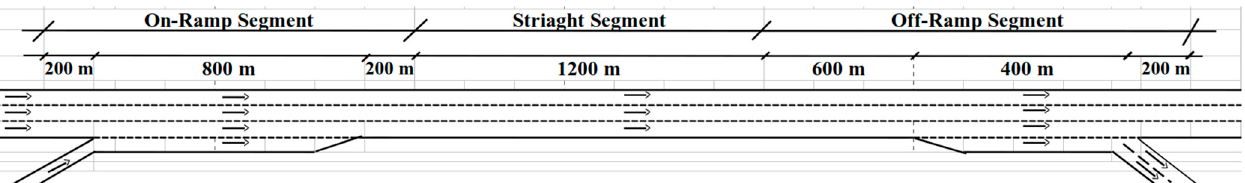
Figure 2. Hypothetical highway